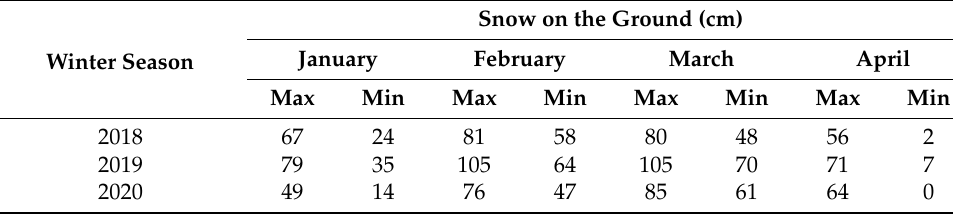
Snow on the Ground